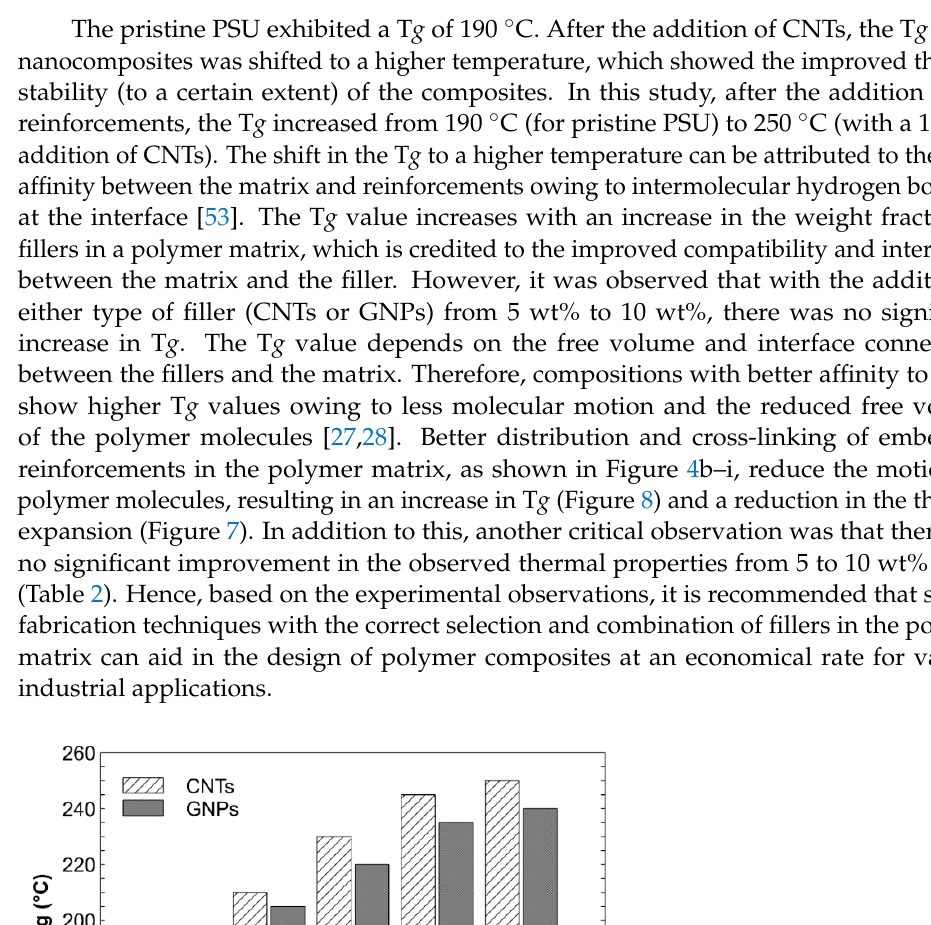
Figure 8. Effect of adding CNTs and GNPs on glass transition temperatures (T g ) of composites.